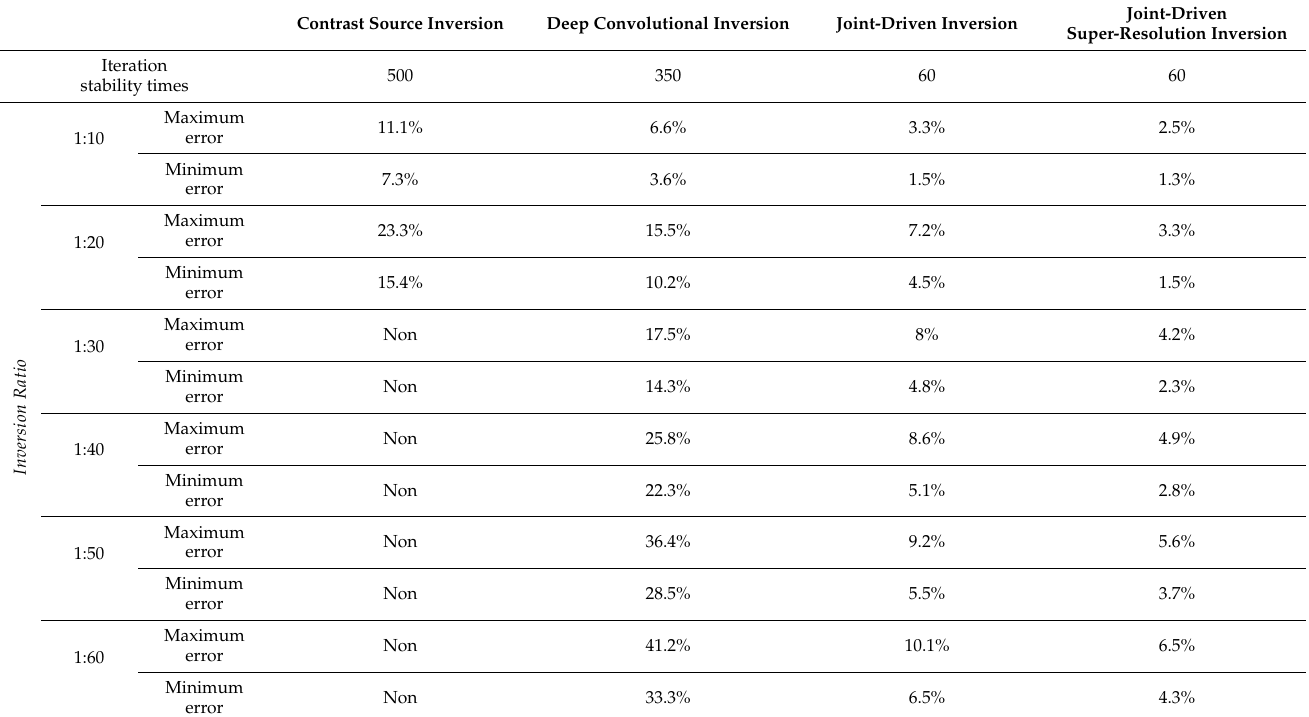
Table 5. Comparison by the Four